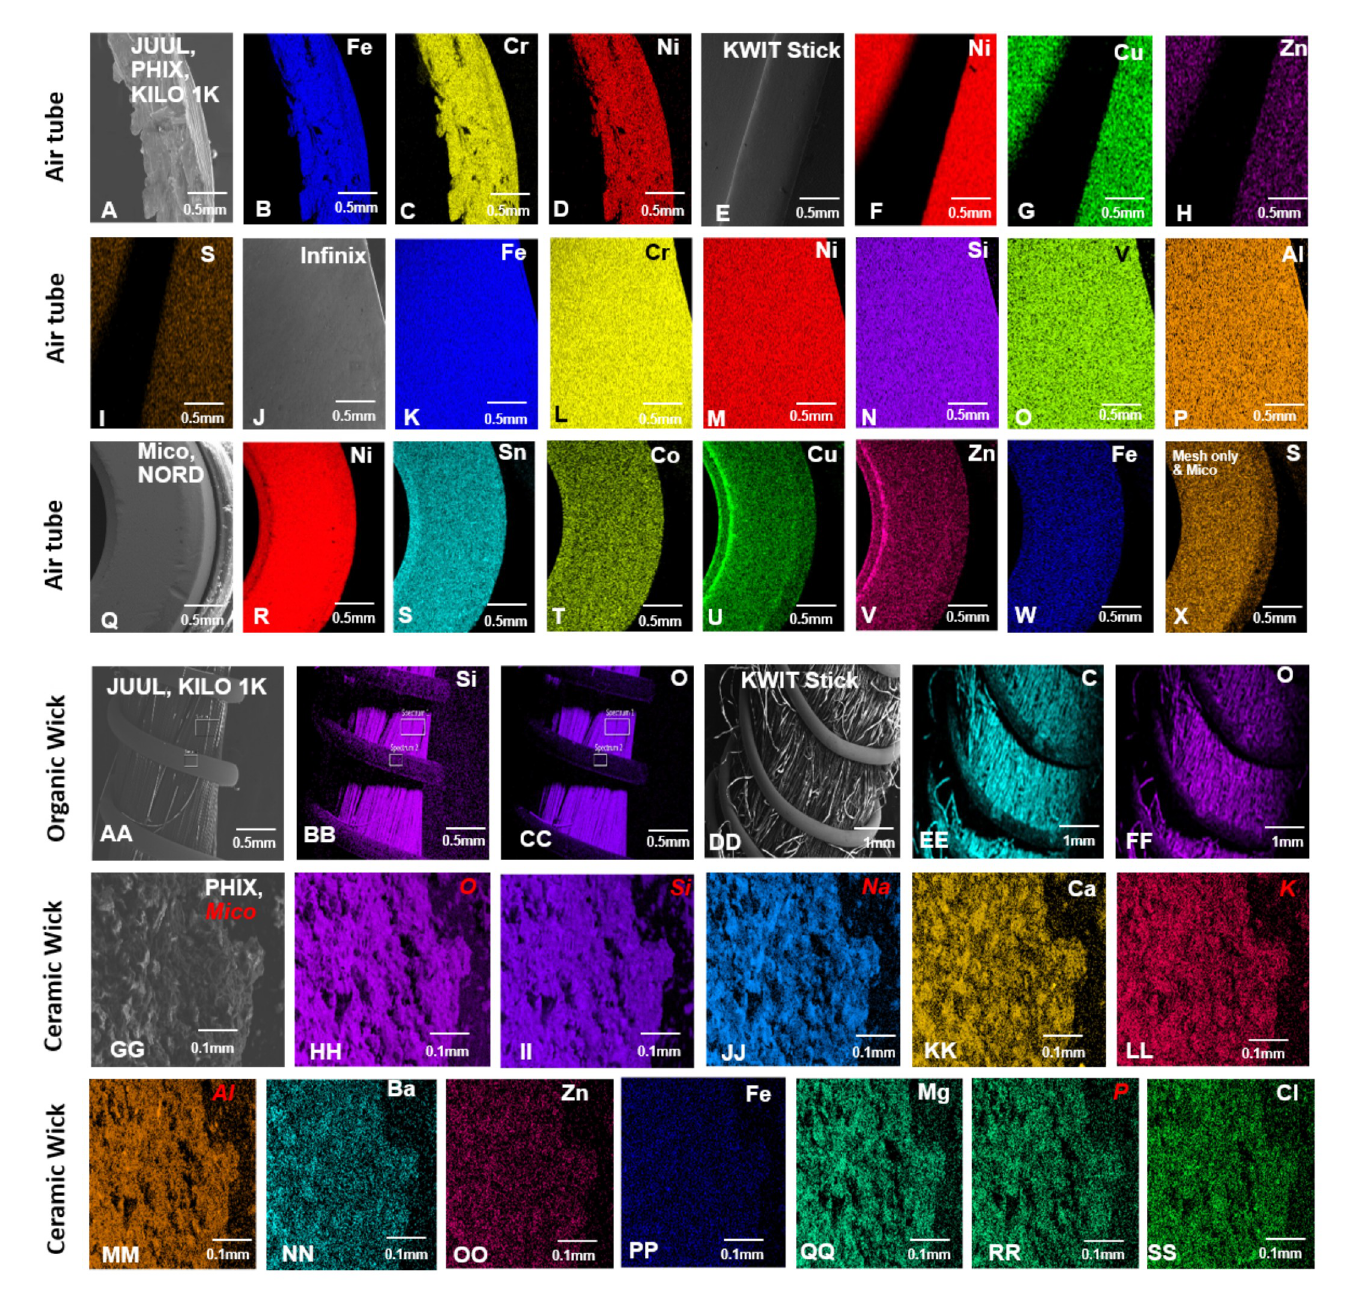
Fig 5. SEM images and EDS elemental maps of the air tubes and wicks from pod EC atomizers. JUUL ™ , PHIX, and Kilo 1K (A) were made of iron (B), chromium (C), and nickel (D). KWIT Stick (E) was made of nickel (F), copper (G), zinc (H), and sulfur (I). SMOK Infinix (J) was made of iron (K), chromium (L), nickel (M), silicon (N), vanadium (O), and aluminum (P). SMOK Mico and NORD (Q) were made of nickel (R), tin (S), cobalt (T), copper (U), zinc (V), iron (W), and sulfur (X). Organic wicks in JUUL ™ and Kilo 1K (AA) were made of silicon (BB) and oxygen (CC), and KWIT (DD) was made of carbon (EE) and oxygen (FF). PHIX and SMOK Mico (GG) had ceramic wicks consisting of iron (HH), silicon (II), sodium (JJ), calcium (KK), potassium (LL), aluminum (MM), barium (NN), zinc (OO), iron (PP), magnesium (QQ), phosphorus (RR), and chlorine (SS). Elements highlighted in red for ceramic wicks were present only in SMOK Mico.